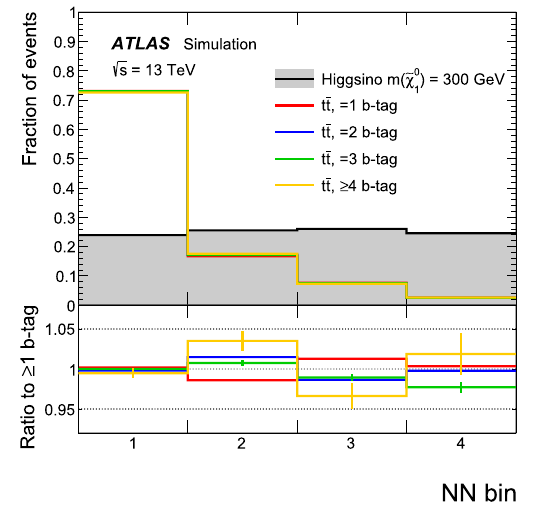
Fig. 2 Output distribution of the NN discriminant in the six-jet slice, evaluated over a signal sample and t ¯ t background split into the differ- ent b -jet regions. The bottom panel shows the ratio of the NN output distribution for t ¯ t background in each b -jet region to the distribution in an inclusive region with at least one b -jet. The NN output distribution is invariant with respect to the number of b -jets in the selection, with differences per bin below